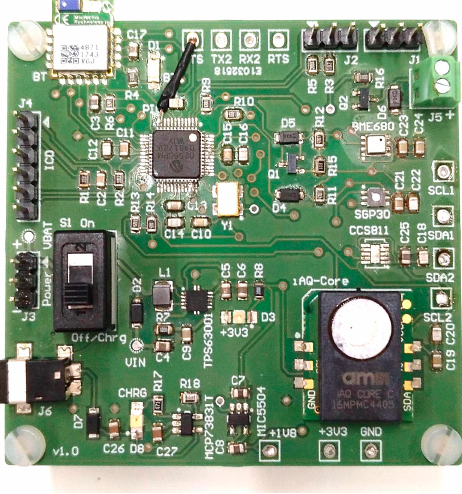
Figure 1. Image of the proposed electronic nose.